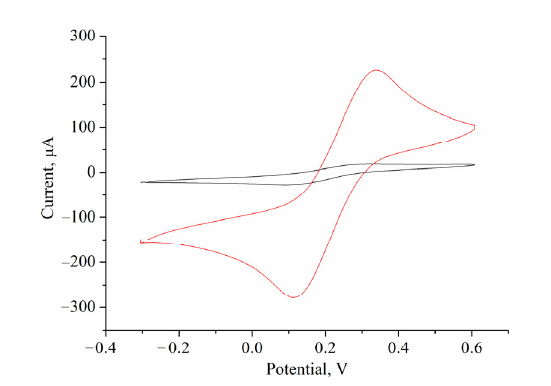
Figure A2. C yclic voltammetry (CV) study of the bulk GE (black) and the modified nCuCe/GE (red) in solution containing 10 mM K 3 Fe(CN) 6 , 100 mM KCl, and 50 mM NaOAc, pH 4.5.